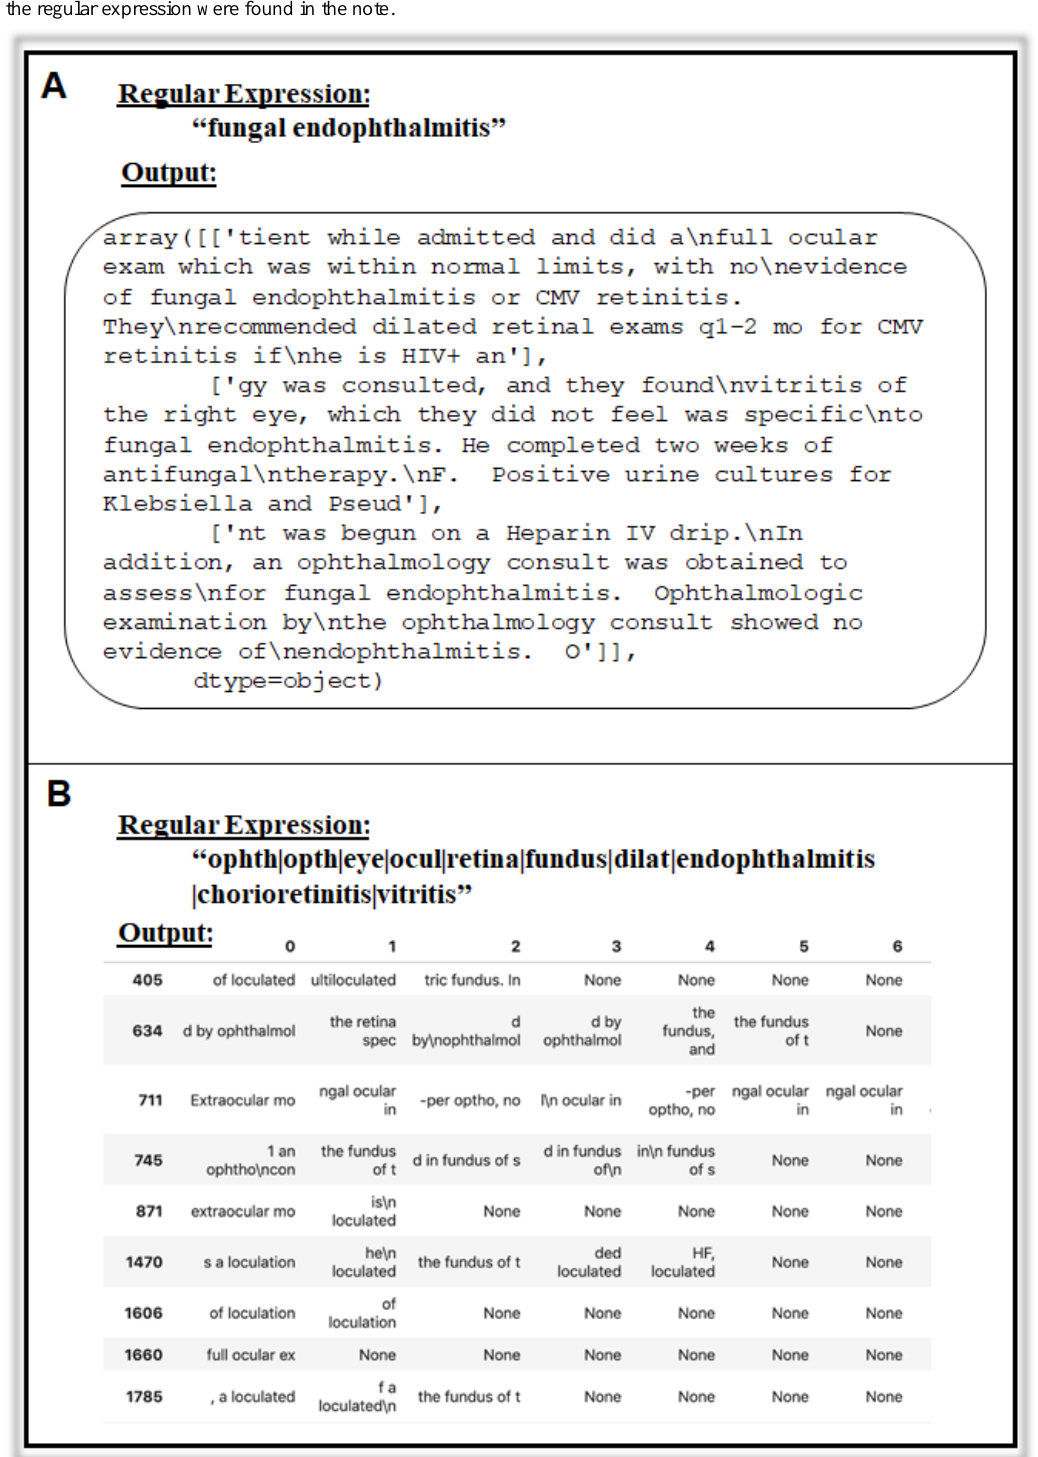
Figure 2. Examples of output from regular expressions screening for fungal endophthalmitis. (A) Output with 100 characters on each side from 3 patients with “fungal endophthalmitis” mentioned. (B) Output with 5 characters on each side from a multi-term regular expression. Rows indicate patients, and columns indicate notes. In this example illustration, only the first 6 notes are displayed for a sample of patients. “None” indicates no matches from the regular expression were found in the